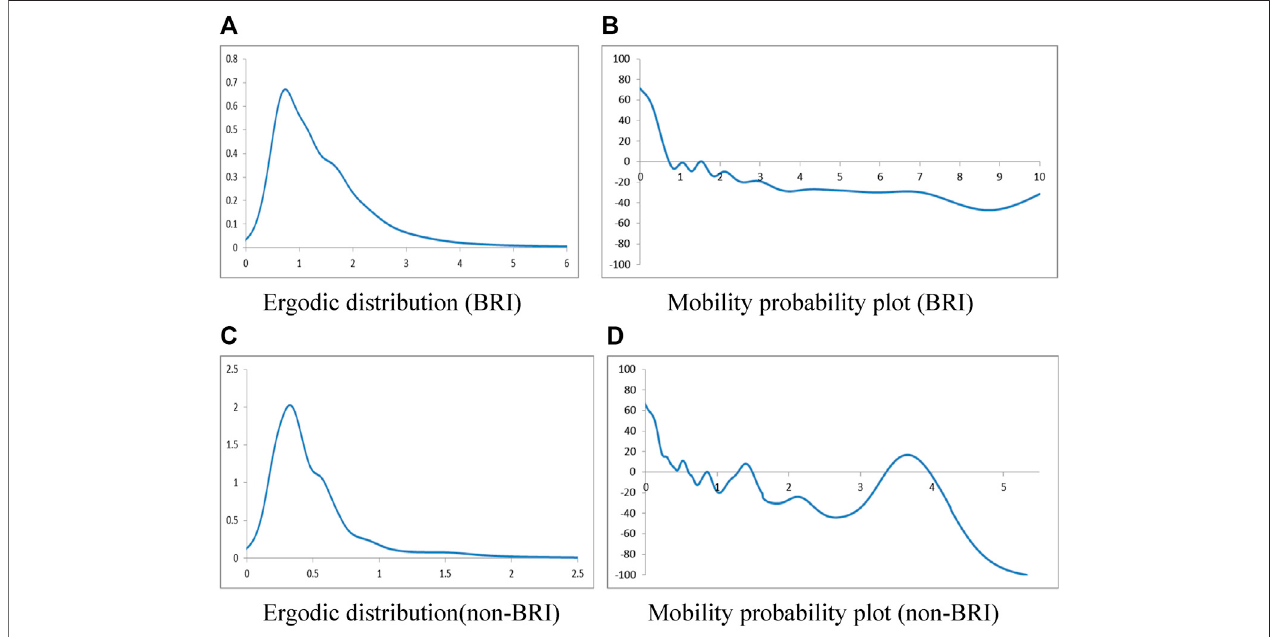
FIGURE 2 | Ergodic distribution and Mobility probability plot of carbon emission per GDP. (A) Ergodic distribution (BRI). (B) Mobility probability plot (BRI). (C) Ergodic distribution (non-BRI). (D) Mobility probability plot (non-BRI).